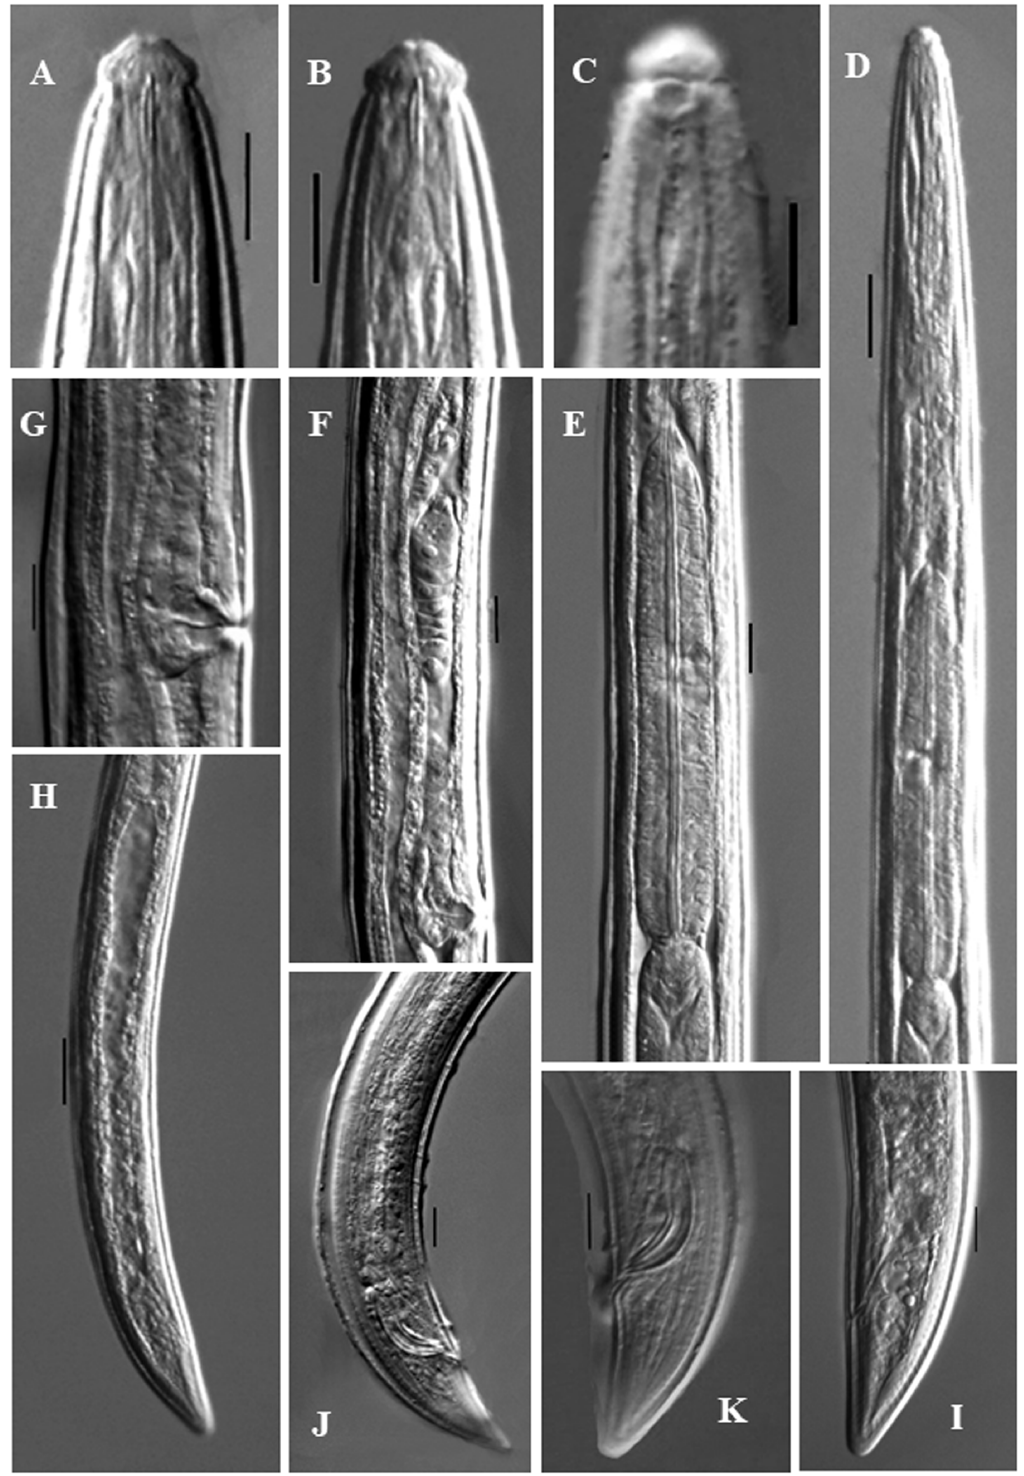
Fig. 2. Tylencholaimus mirabilis (Bütschli, 1873) (LM photographs). A–B . Female anterior region. C . Female anterior region showing amphid. D . Female pharyngeal region. E . Female expanded part of pharynx. F . Female genital system. G . Vulval region. H . Female posterior region. I . Female posterior end. J–K . Male posterior end. Scale bars: A–C, E–G, I–K = 10 μm; D, H = 20